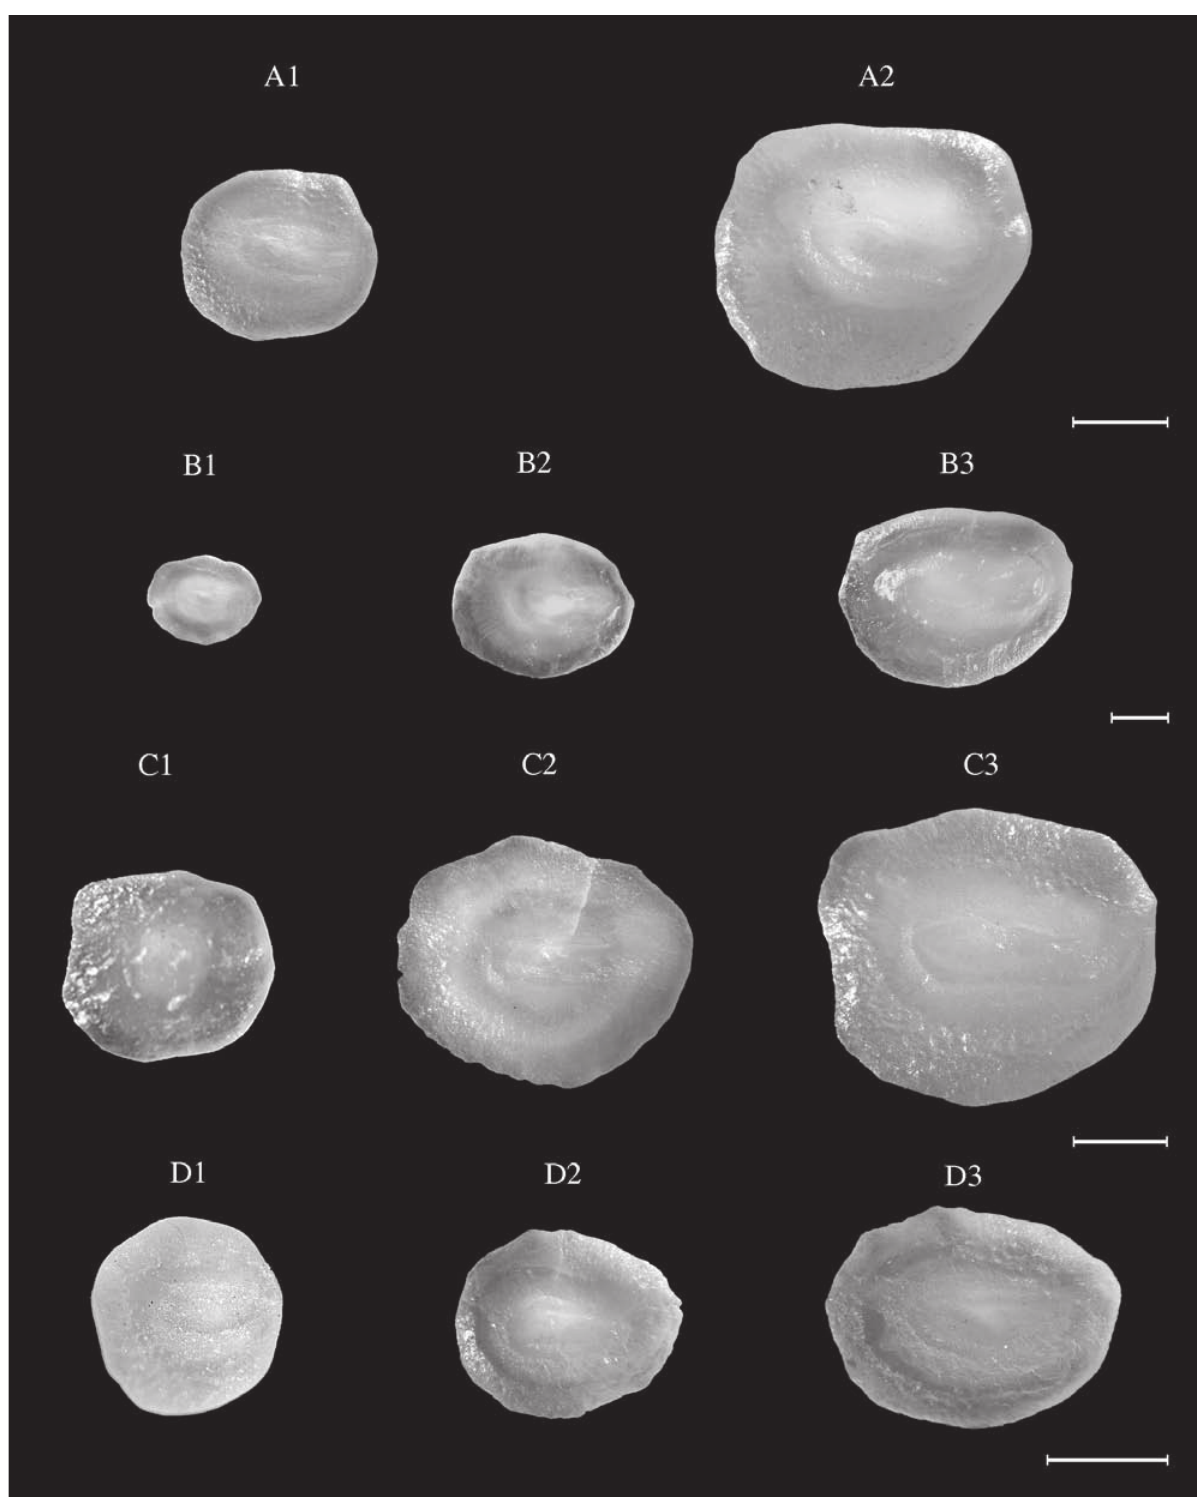
Fig. 92. – Microchirus boscanion (NEA). TL: A1, 9.0 cm; A2, 13.2 cm. Microchirus ocellatus. TL: B1, 7.5 cm (NEA); B2, 14.5 cm (WM); B3, 15.5 cm (WM). Microchirus variegatus. TL: C1, 9.0 cm (WM); C2, 12.3 cm (NEA); C3, 17.2 cm (NEA). Monochirus hispidus. TL: D1, 5.5 cm (WM); D2, 8.3 cm (NEA); D3, 11.3 cm (NEA). Scale bar = 1